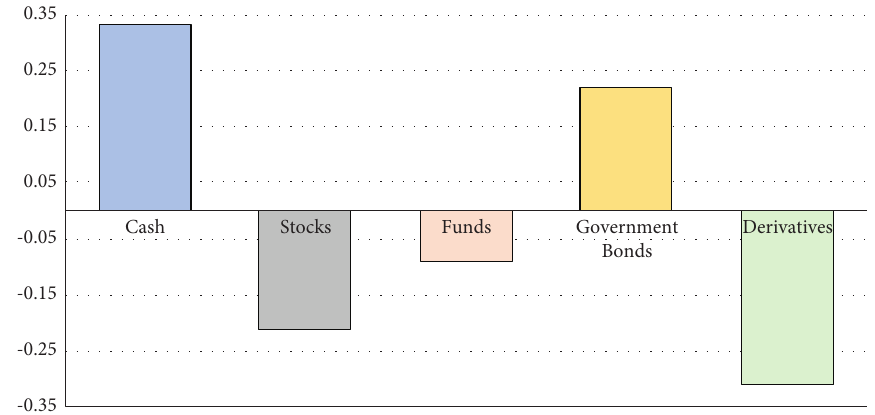
Figure 4: Heterogeneous effects of aging ( percentage_60 ) on the share of different types of financial assets